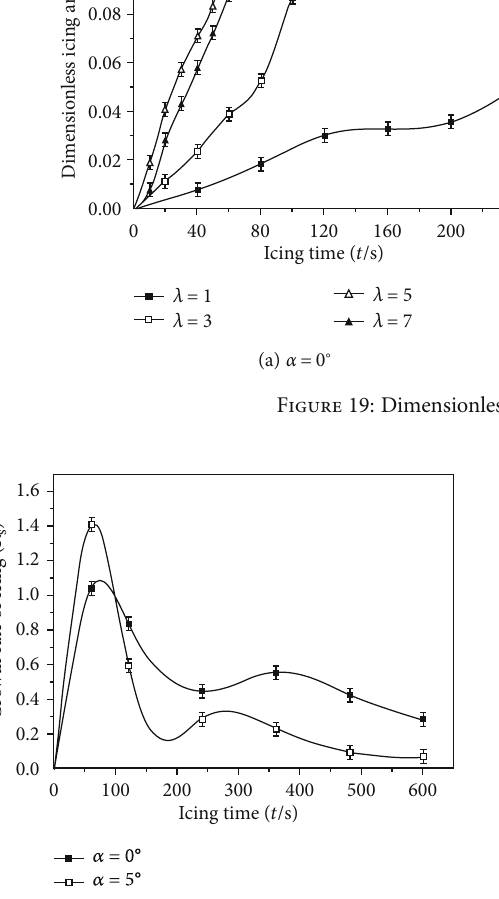
Figure 20: Growth rate of icing in static